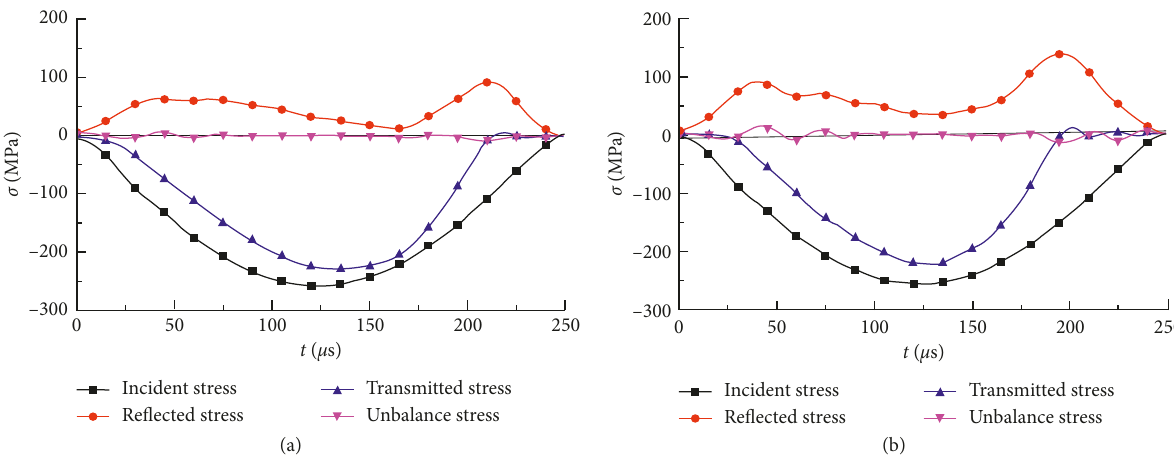
Figure 3: The incident, reflected, transmitted, and unbalance stresses when Young’s modulus is 28GPa: (a) c